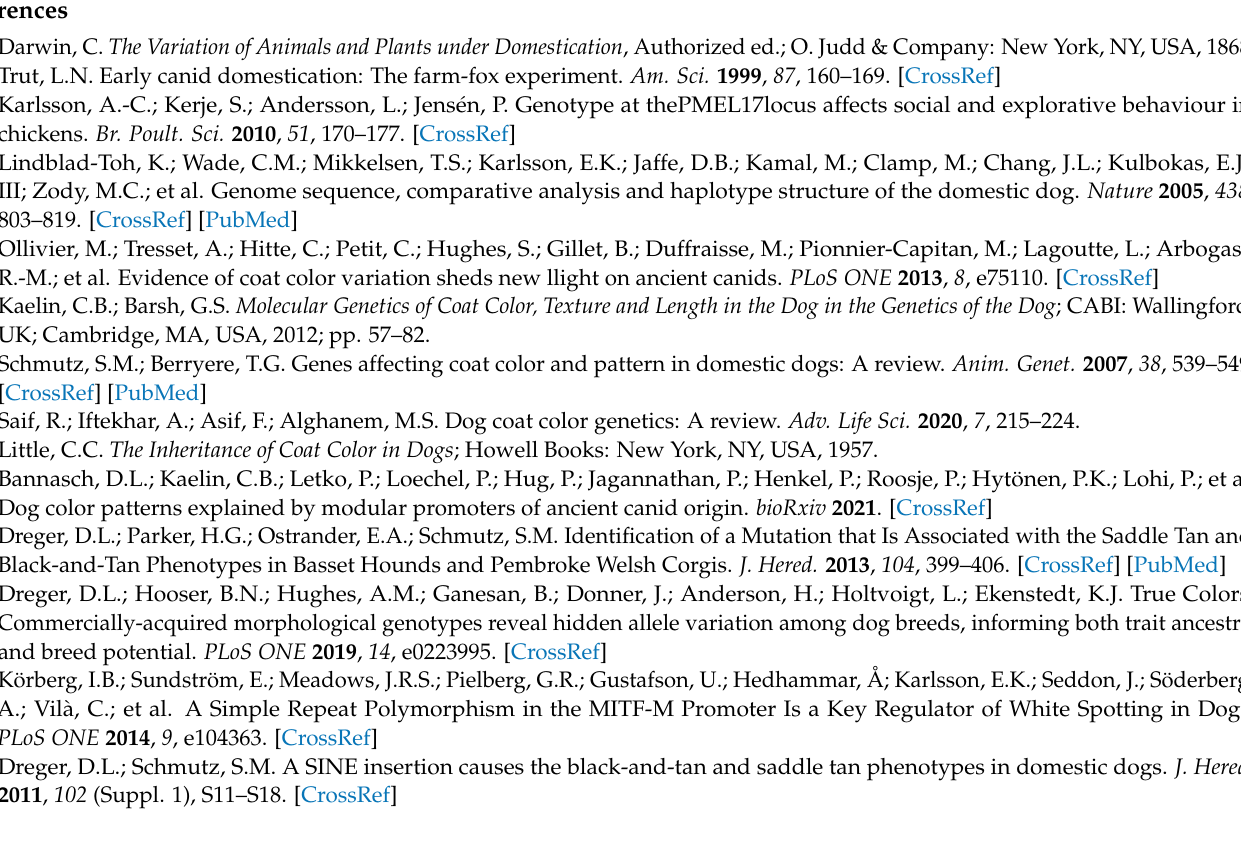
markers face, Table S2: SNP markers neck, Table S3: SNP markers leg, Table S4: SNP markers overall white, Table S5: SNP markers saddle, Photos S1: Photos of representative